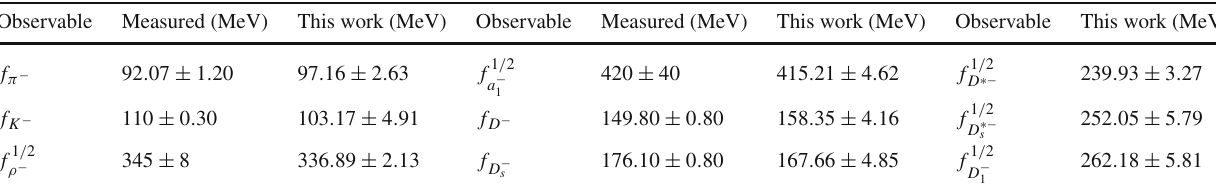
Table 1 Our predictions for the decay constants of nine selected mesons. The measured value are taken from [1–3]